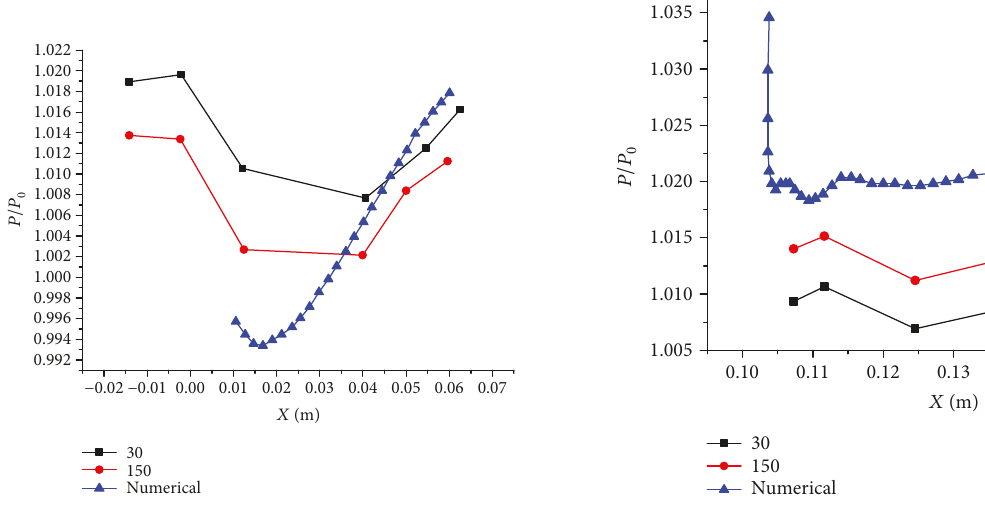
Figure 13: Pressure distribution on the top wall of predi ff user.